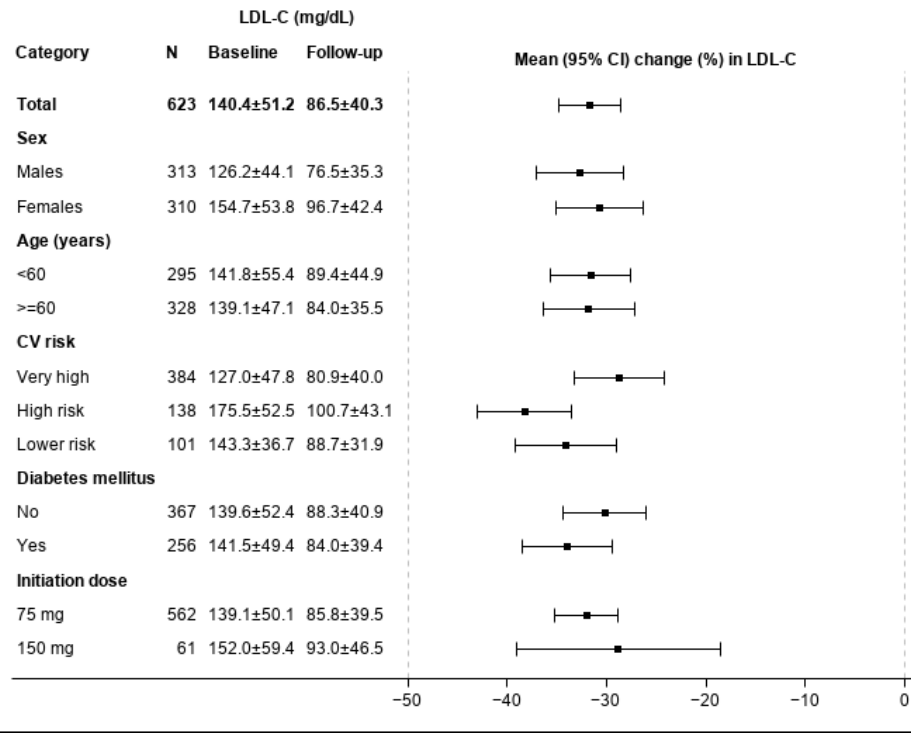
Figure 3. Proportion (%) of patients achieving LDL-C goals during study period. Proportion of pa- tients and 95% confidence intervals of patients achieving LDL-C target goals according to 2019 ESC/EAS guidelines. Abbreviations: CV: Cardiovascular; LDL-C: Low-density lipoprotein choles- terol.